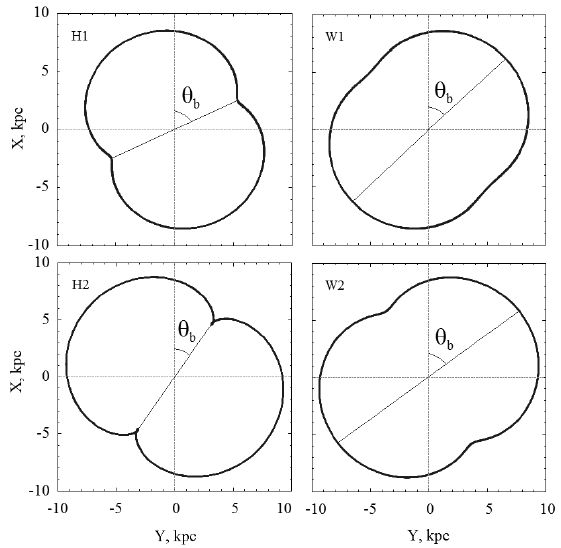
Fig. 2. Resonant periodic orbits in the bar rotating frame constructed from averaged data for stars of the streams H1, H2 and W1, W2 in an axisymmetric Galactic potential. The Galactic center lies at the coordinate origin; the Sun’s coordinates are ( x, y ) = (8 . 5 , 0) kpc; θ b is the bar angle counted from the direction to the Sun.